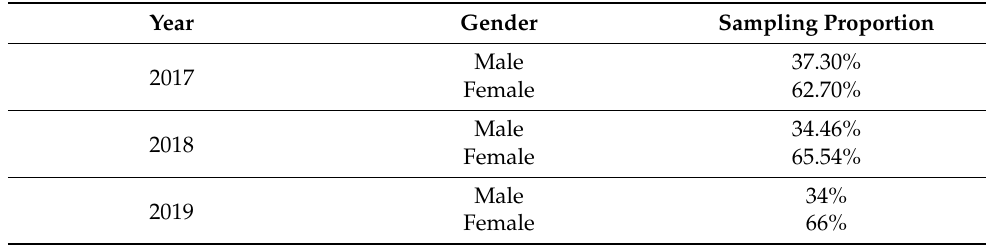
Table 4. Gender proportion, data from [19].